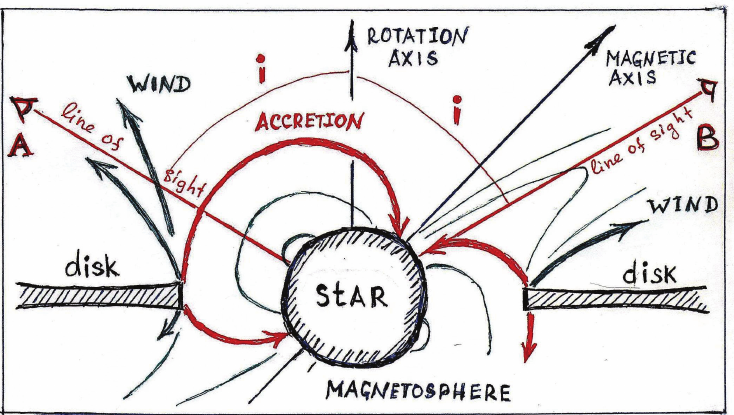
Figure 9. Schematic picture of the region of disk/star interaction near HD259431, where the magnetic axis is inclined relative to the rotation axis. The star, disk, magnetosphere and wind zone are shown in the figure. The picture is presented in the reference frame of the star. Two directions of the line-of-sight are indicated. From direction A the line of sight intersects the wind zone at low magnetic latitudes, from direction B the line of sight intersects the accretion stream inside the magnetosphere at high magnetic